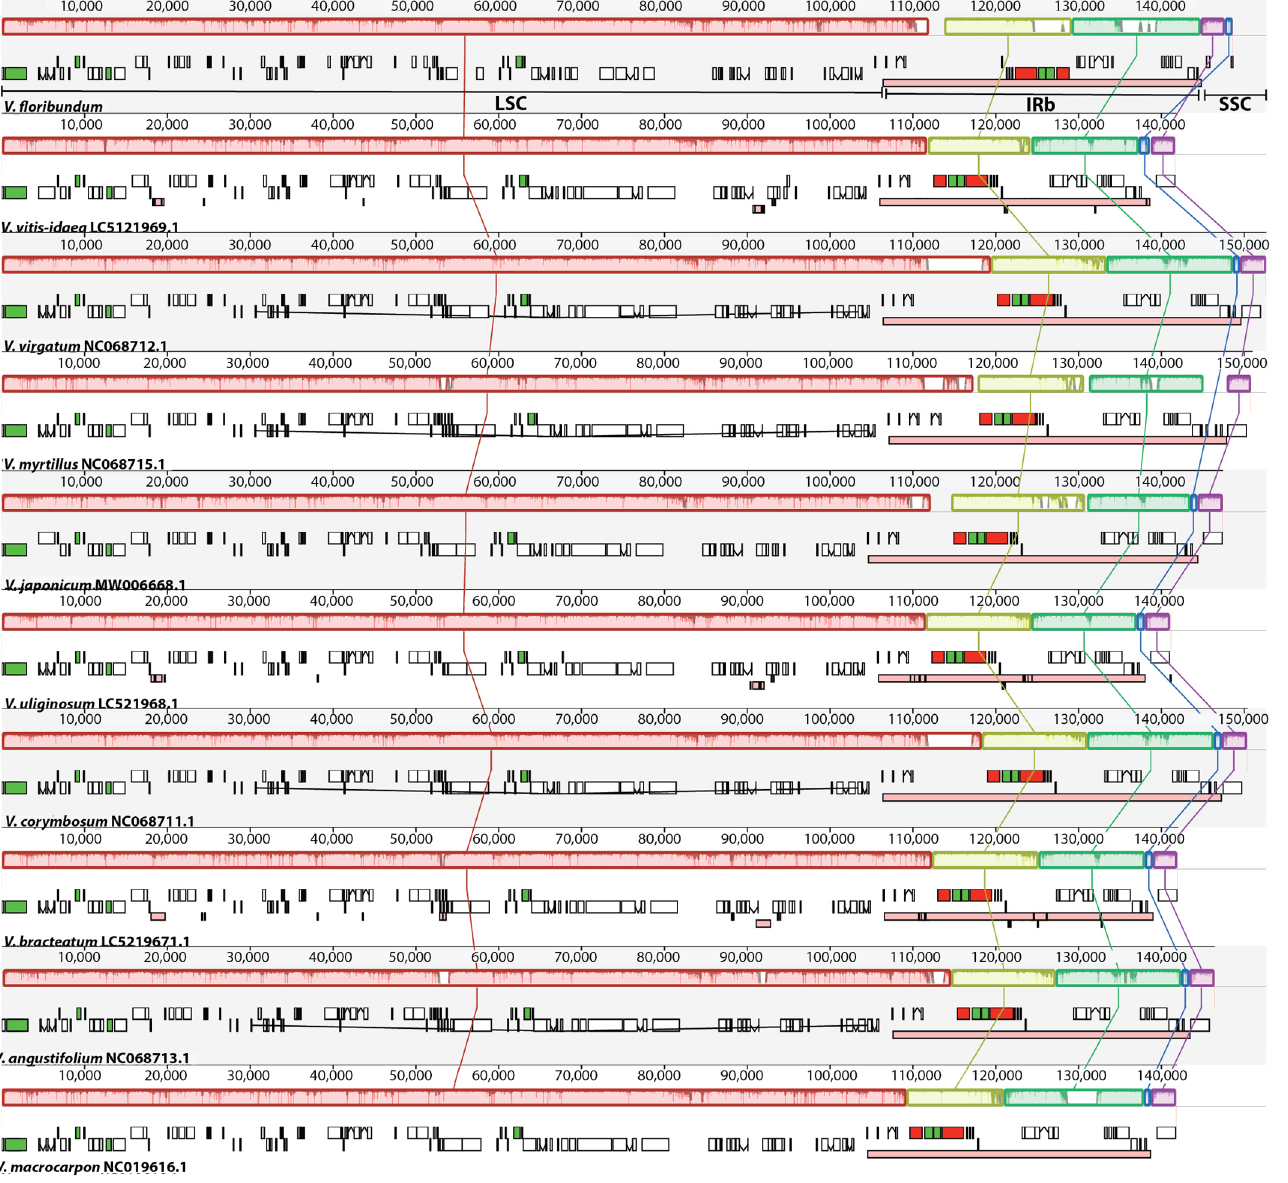
Figure 5. Colinear analysis using progressive Mauve of V. floribundum and other nine Vaccinium species cp genomes. The LCBs are depicted as shaded colored boxes connected by a line. The numbers on top of the x-axis indicate the coordinates in bp in the analyzed genomes. LSC, IRb, and SSC regions are presented by blue arrows in the V. floribundum cp genome.